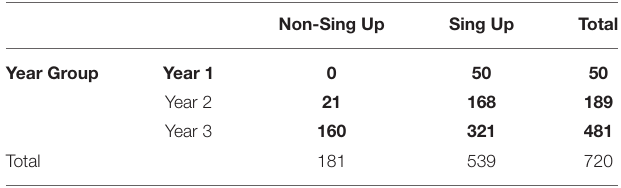
TABLE 1 | Research participants in school years 1, 2, and 3. Non-Sing